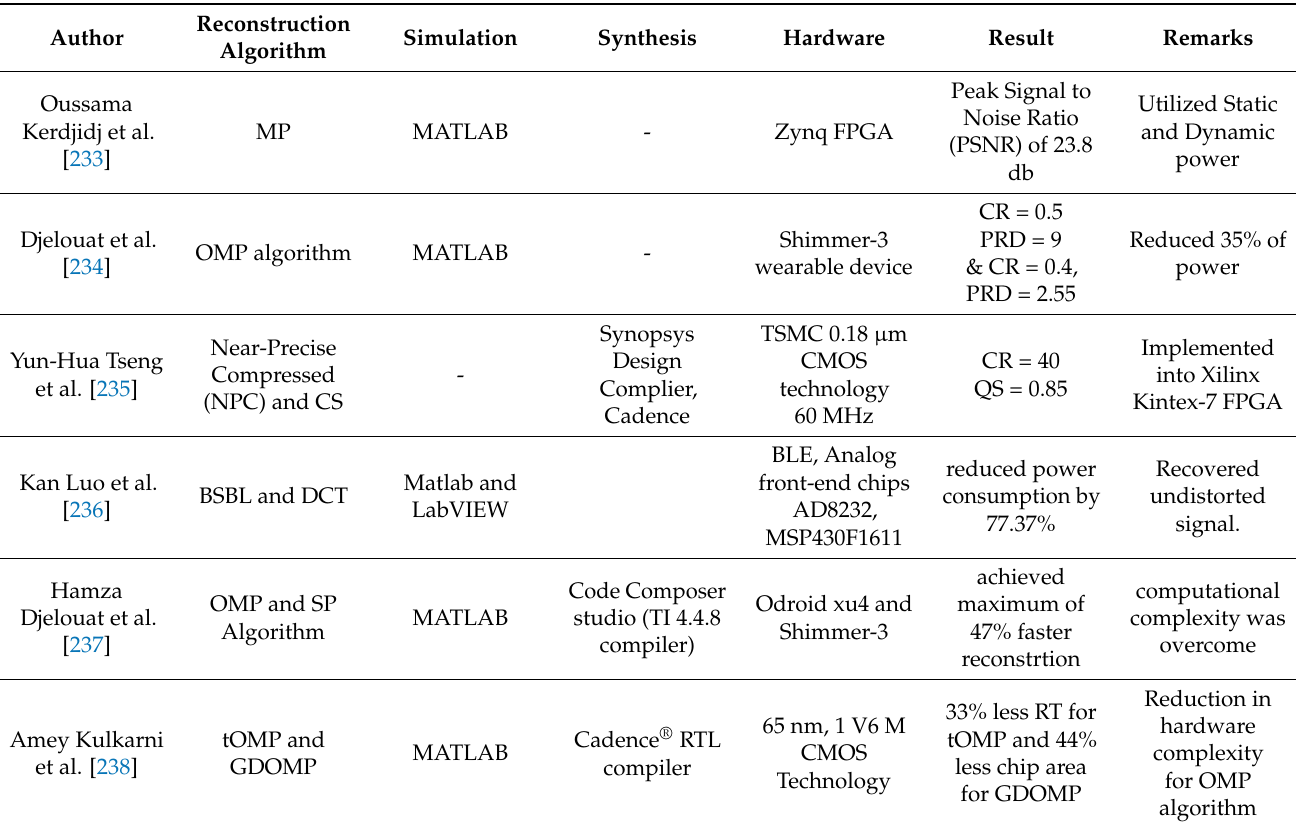
Table 5. CS models with hardware implementation. Note: when quantifiable data is not available it is marked as-